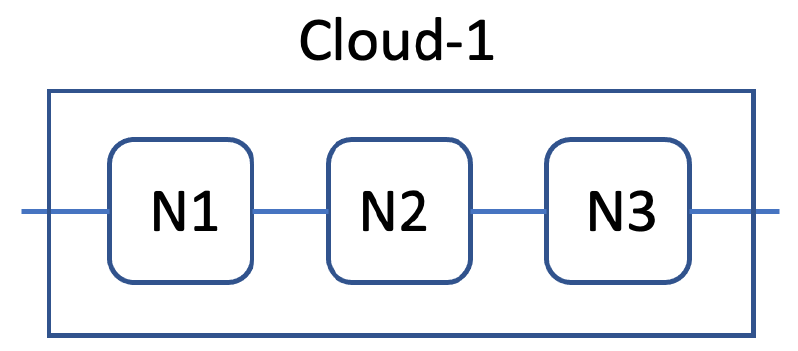
Figure 9. Sample cloud structure consisting of three nodes, each running a different